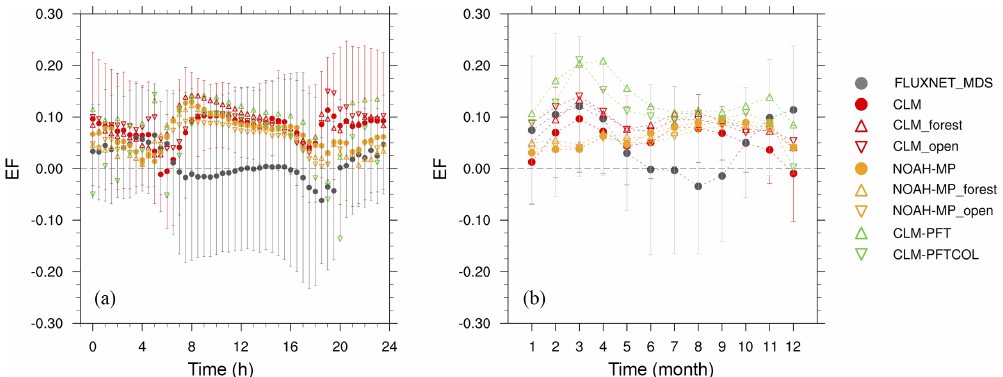
Figure 7. Change in the summer diurnal (a) and seasonal (b) cycles of EF (unitless) due to LULCC from forest to open land (open − forest). The observed EF (FLUXNET_MDS) is calculated based on the MDS gap-filled LE (LE_F_MDS) and H (H_F_MDS).